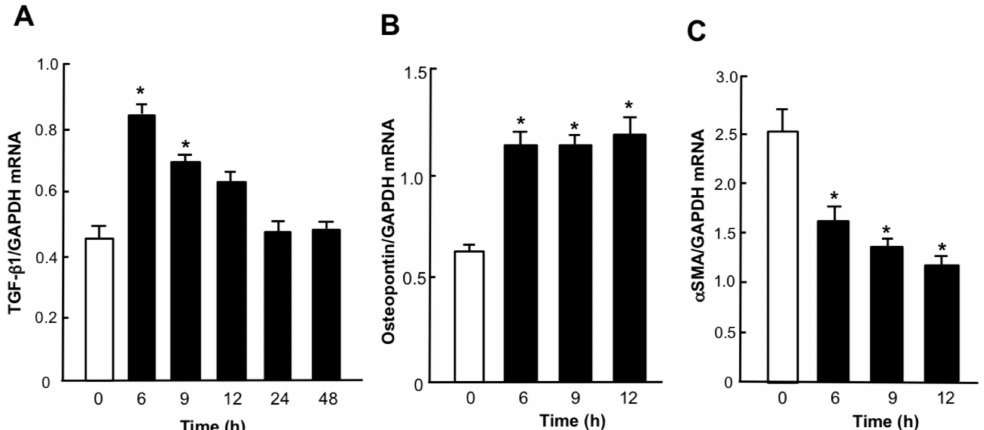
Figure 1. Changes in the expression of TGF- β 1 and phenotype marker mRNAs in rat mesangial cells (MCs) with high glucose. Quiescent MCs from Wistar Kyoto rats were incubated with 25 mM glucose for 6 to 48 h. Total RNA was extracted, and the abundance of TGF- β 1 ( A ), osteopontin ( B ) and α SMA ( C ) mRNAs was evaluated by real-time polymerase chain reaction analysis. Relative gene expression was analyzed by the comparison to GAPDH mRNA. Data are the mean ± SEM ( n = 6). * p < 0.05 versus 0 h.